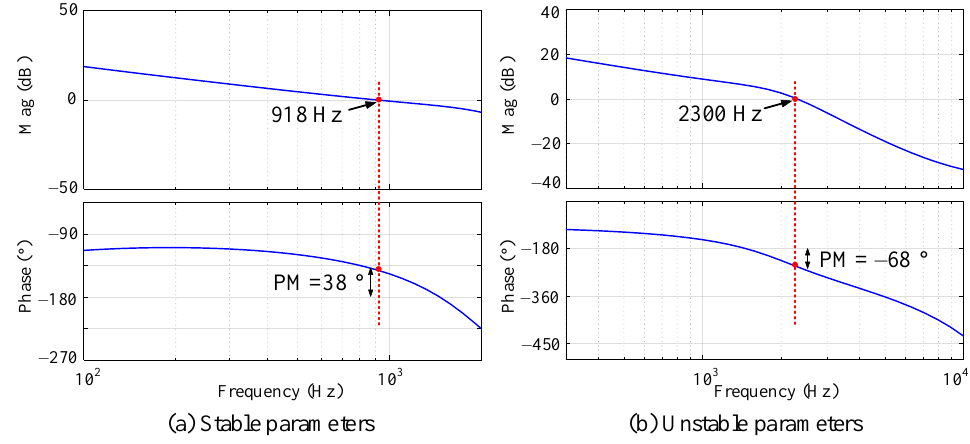
Figure 7. The bode diagram of the open-loop transfer function of the voltage control system.